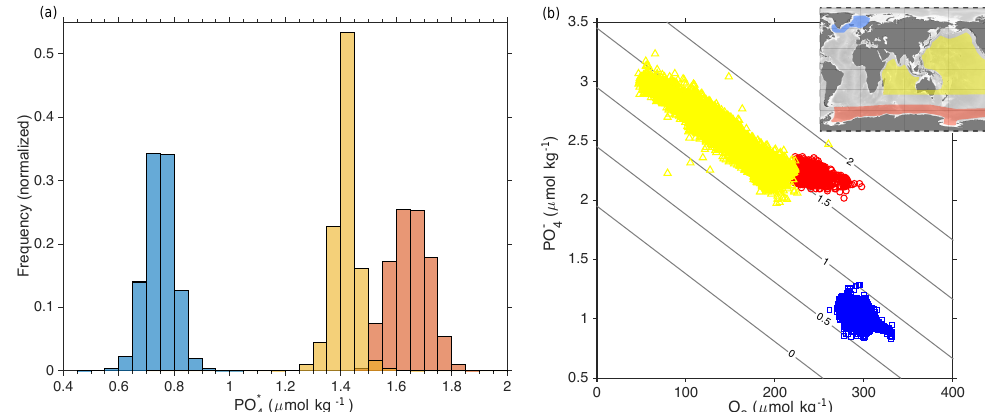
Figure 2. End member PO ∗ values for deep North Atlantic waters (blue) and deep Southern Ocean waters (red), along with deep Indo- 4 Pacific waters (yellow). Data are from GLODAPv2 (Key et al., 2015; Olsen et al., 2016) and taken from the regions shown in the inset map. North Atlantic data are > 1500m and have CFC-11 > 0.5pmolkg − 1 ; Southern Ocean data are > 1500m, have CFC-11 > 0.5pmolkg − 1 , and neutral density > 28.3kgm − 3 (see Fig. 4); Indo-Pacific data are > 2000m. Normalized histograms of PO ∗ are shown for each region in 4 panel (a) , and the corresponding O 2 and PO 4 concentrations in (b) , contoured with PO ∗ . 4